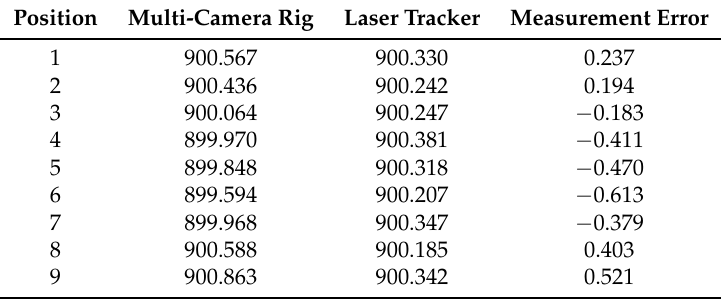
Table 2. Measurement error of travel distance (mm).